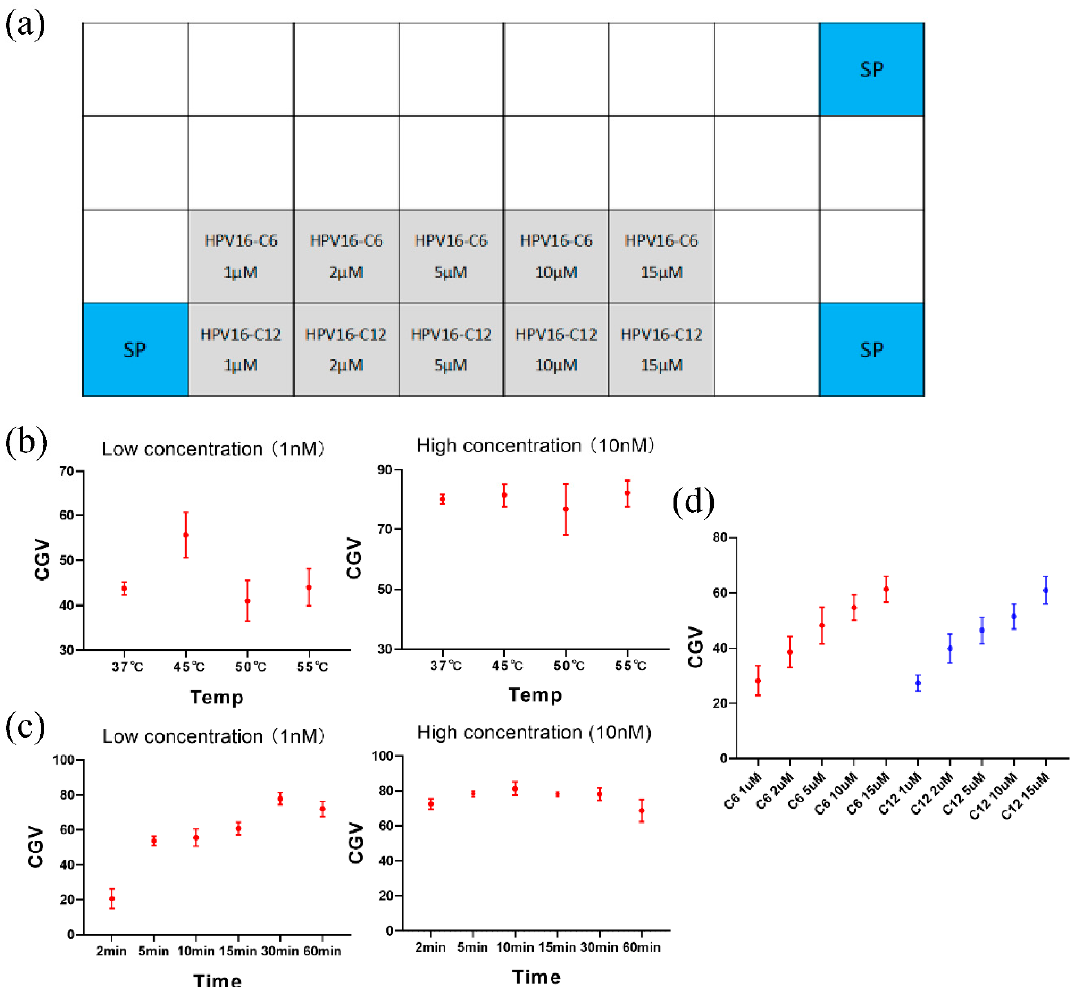
Figure 5. The CGV of the reverse dot hybridization under different conditions, the higher the CGV, the better the detection result. ( a ) Microarray is fabricated with two differently modified HPV16 genotype probes (HPV16-C6, HPV16-C12) at 5 different concentrations (1 µ M, 2 µ M, 5 µ M, 10 µ M, 15 µ M). ( b ) The CGV results of samples with different concentrations under different hybridization temperature conditions. ( c ) The CGV results of samples with different concentrations under different hybridization time conditions. ( d ) The CGV results of two different modified probes with 5 different concentrations, when the sample concentration is 100 pM. Error bars represent standard deviation ( n = 4).